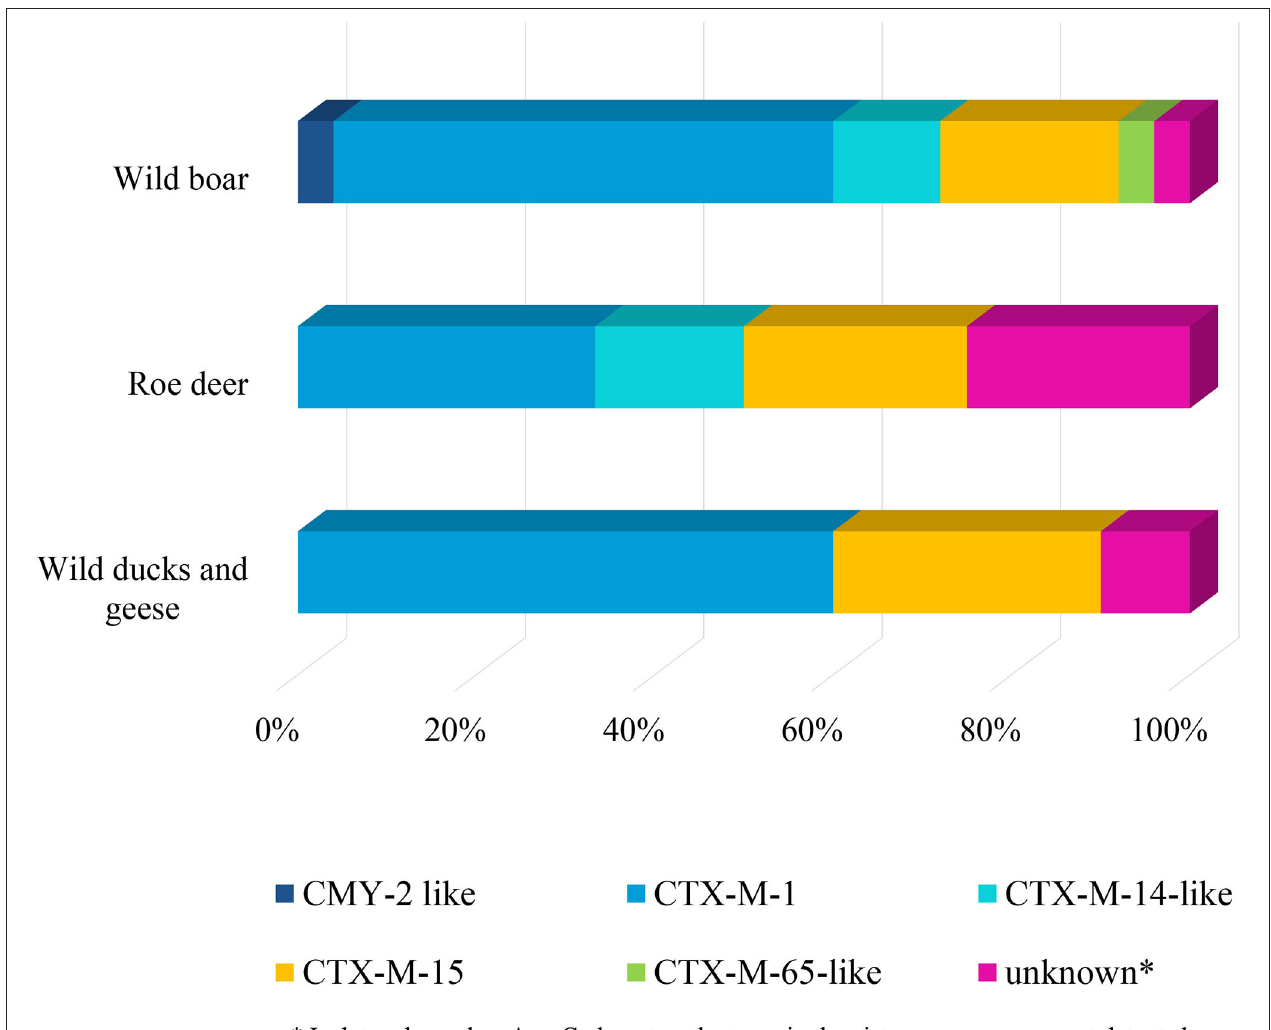
FIGURE 2 | Resistance determinants of E. coli isolates obtained from the selective ESBL/AmpC monitoring of wild boars, roe deer, and wild ducks and